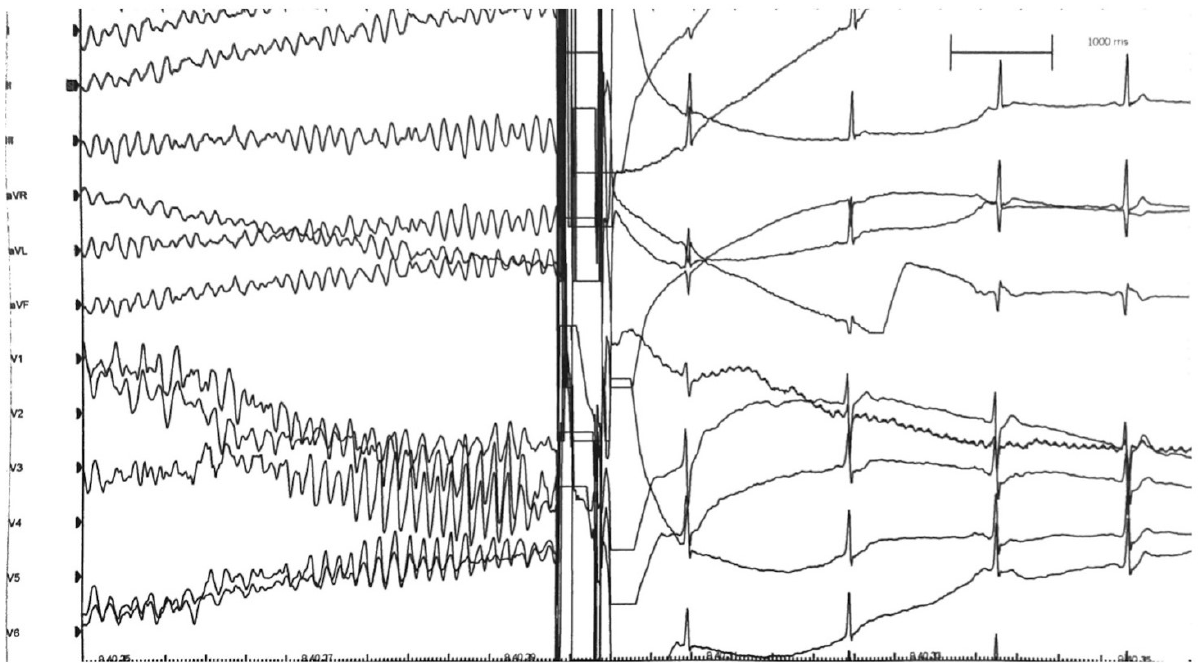
Figure 6. Electrophysiological Study: ventricular fibrillation interruption by external DC shock.